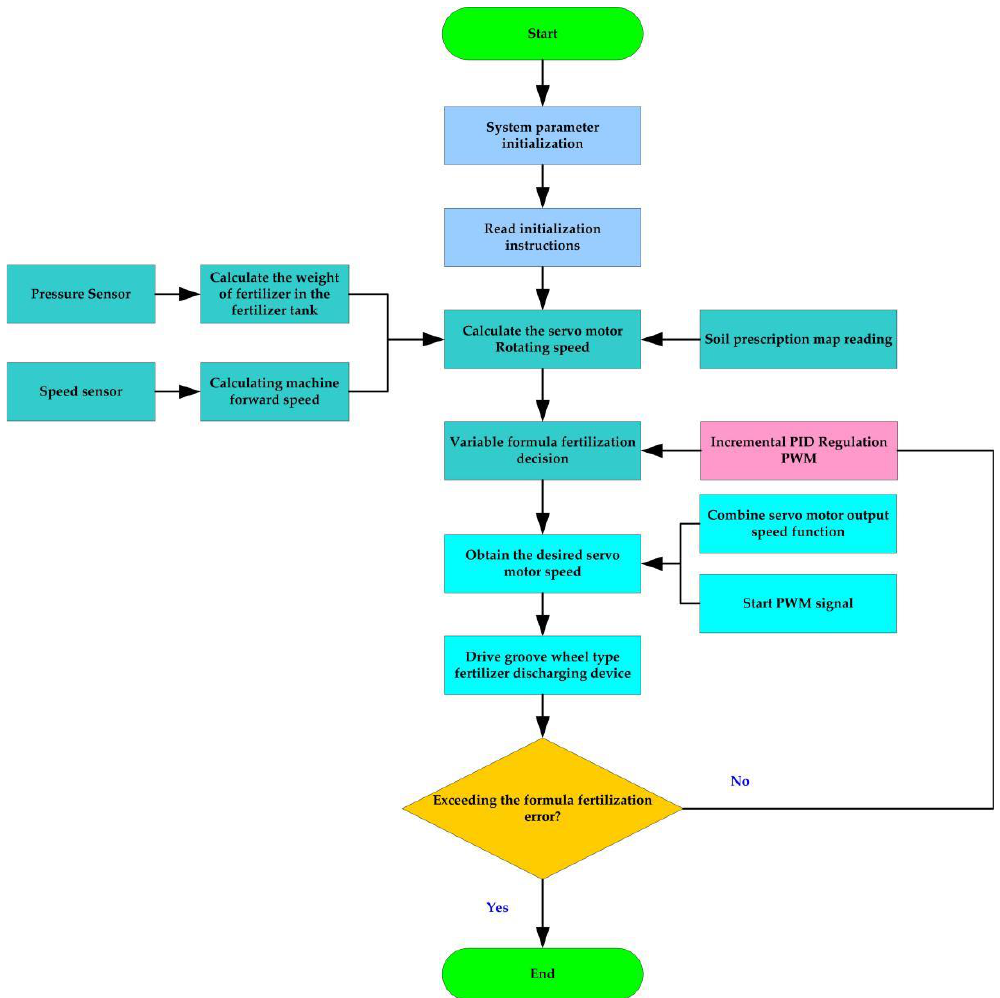
Figure 7. Program flow diagram of software system.